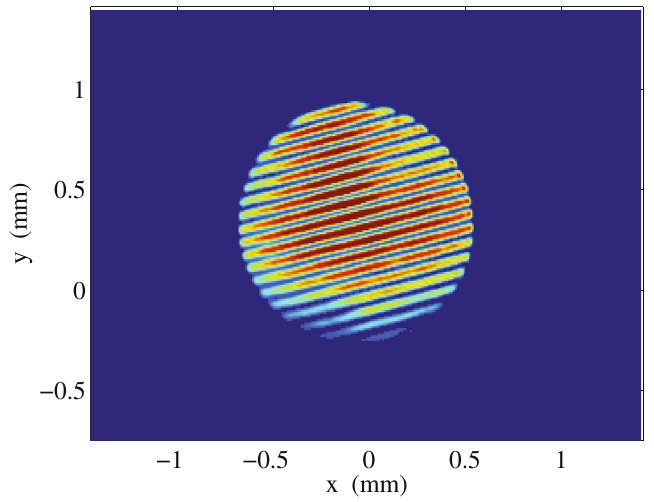
Figure 2. Interference fringes at the Virtual Cathode Camera when the two UV drive lasers are overlapped in